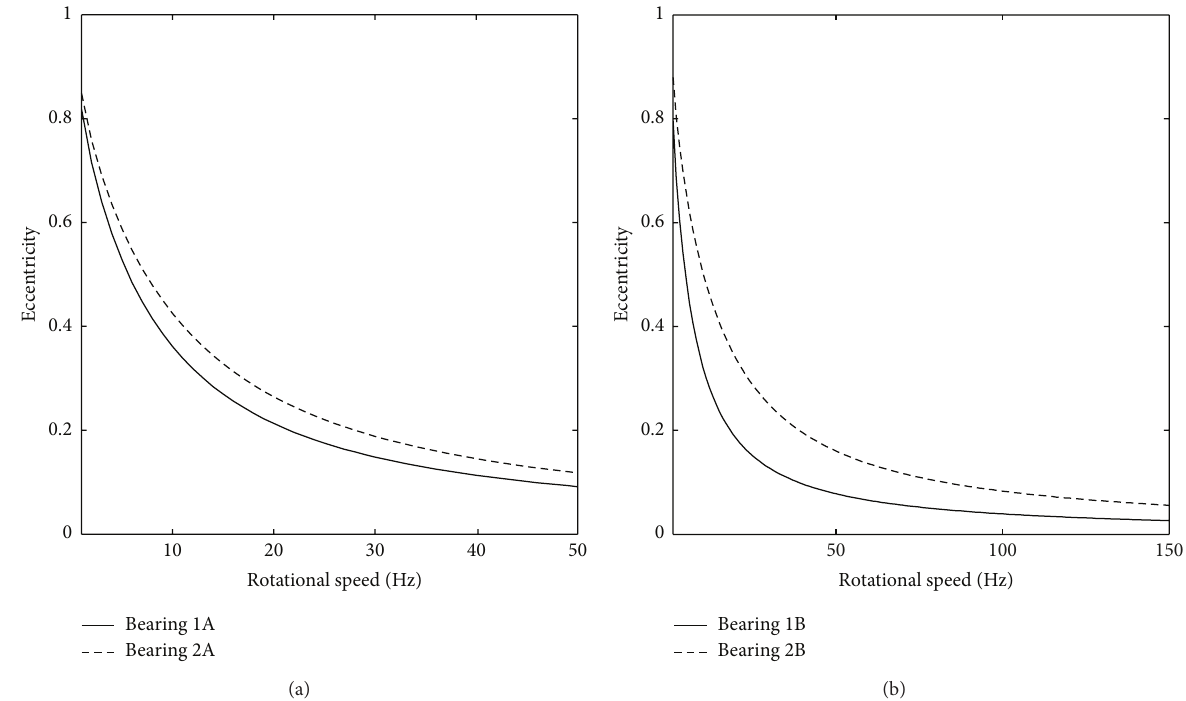
Figure 5: Journal bearings eccentricity: (a) configuration A; (b) configuration